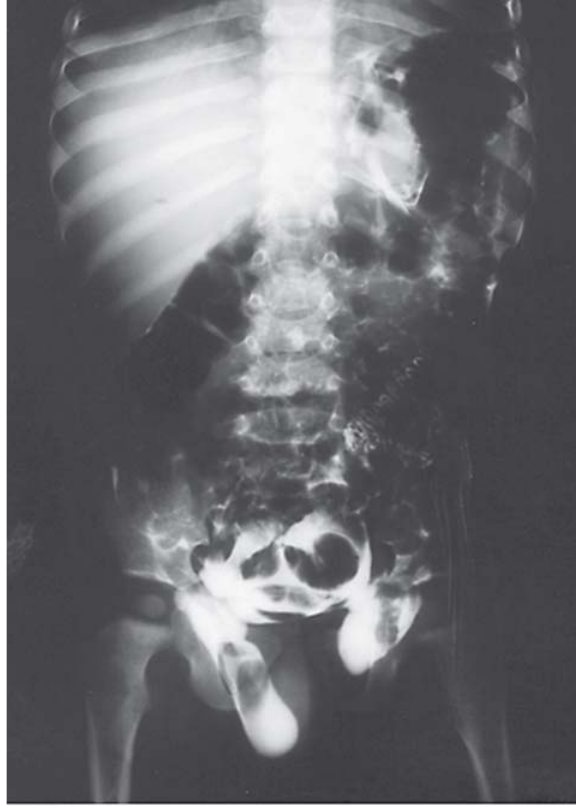
Figure 2 – Herniography of cryptorchid testis. After intraperitoneal injection of contrast medium, anteroposterior pelvis X-rays show an open peritoneal sac on the right side with descended testis and an open peritoneal sac on the left side with undescended testis.